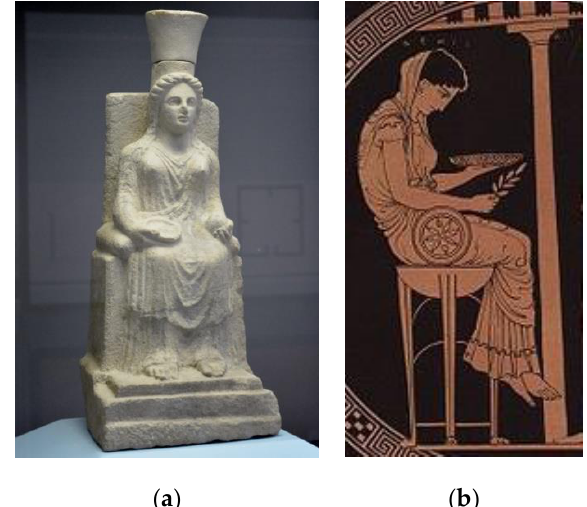
Figure 7. ( a ) Hera on the throne, with phiale on the right and pomegranate on the left (fifth century BC). Copyright © Archaeological Museum of Paestum. ( b ) Attic red-figure kylix of 440–430 BC. Work of the Painter of Kodros, depicting the goddess Themis, second holder of the oracle of Delphi according to Aeschylus. Copyright © Antikensammlung in